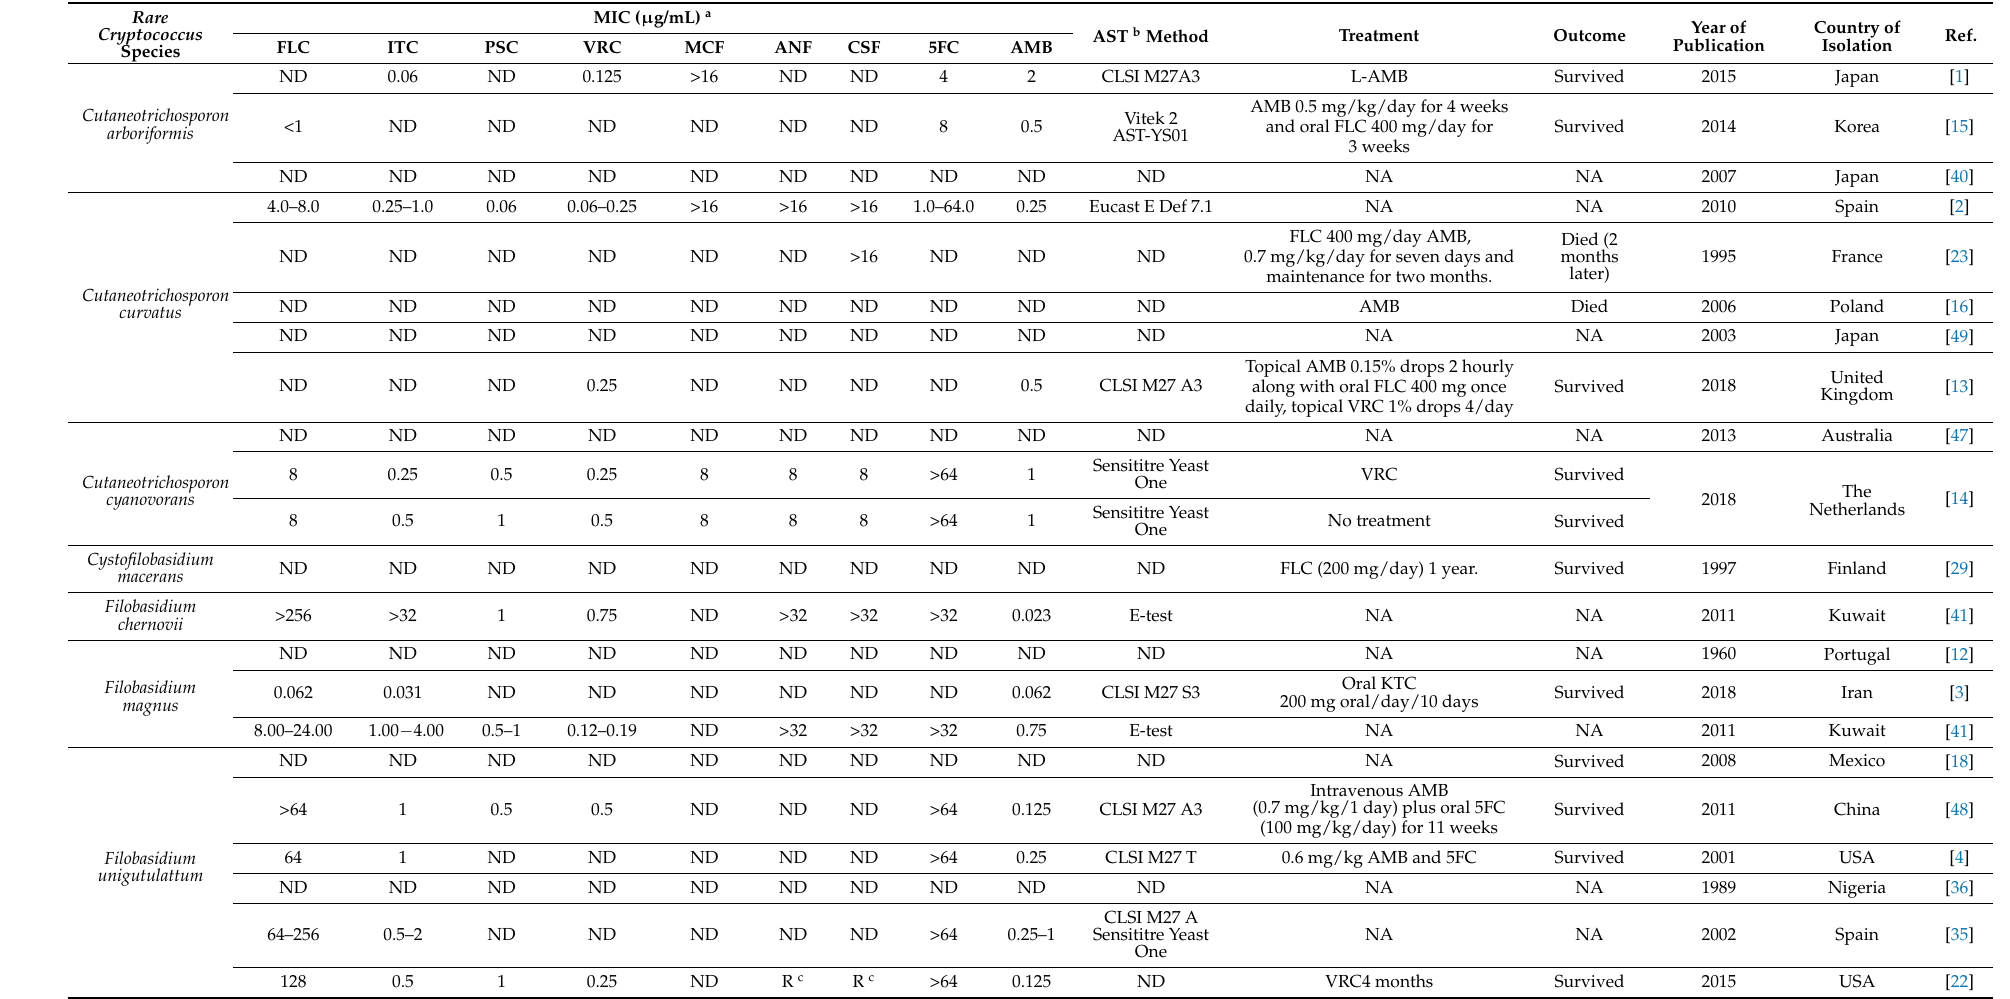
Table 2. Antifungal susceptibility, treatment, and outcome of the studied Cryptococcus